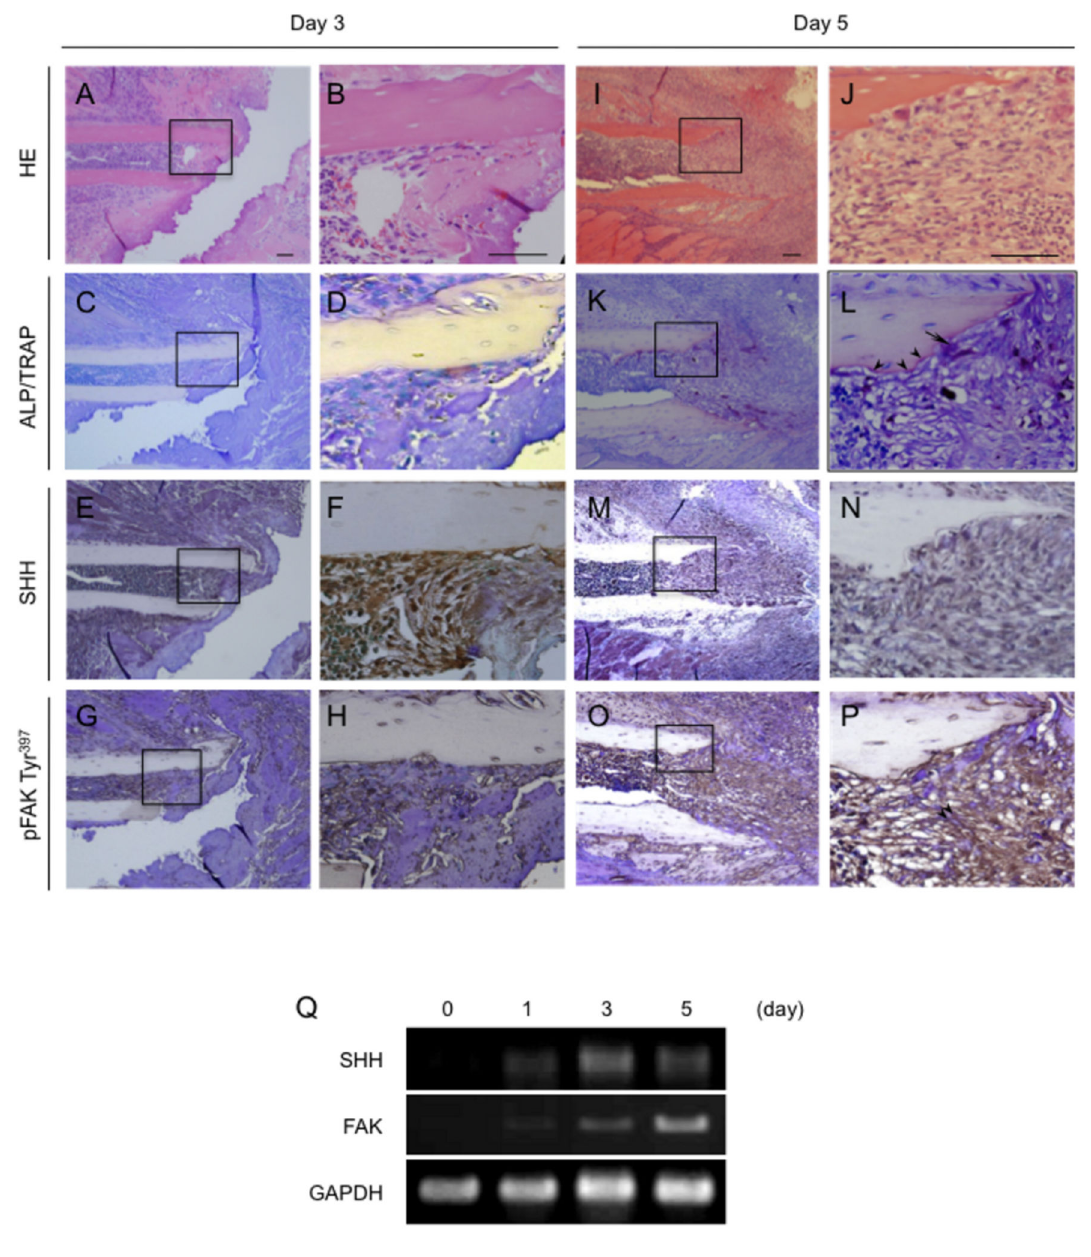
Figure 1. Histological appearance and localization of SHH and pFAK Tyr 397 in fractured mouse ribs at the early stage after fracturing. A-P, Photomicrographs show the healing process at 3 (A-H) and 5 (I-P) after fracturing. Sections were stained with HE (A, B, I and J) or for ALP and TRAP (C, D, K, and L), SHH (E, F, M, and N), and pFAK Tyr 397 (G, H, O, and P). Q, RT-PCR analysis of tissue samples containing ribs and surrounding tissues within 3 mm from the fracture line on days 1, 3, and 5 after the operation. Each right photo showing a histological section is a magnification of the rectangle-delimited area in the corresponding left photo Bar, 100 µm. Arrowheads: osteoblasts. Arrow: osteoclast. Double arrowheads: migrating bone marrow cells. The data from a typical experiment are presented: similar results were obtained in repeated experiments. doi: 10.1371/journal.pone.0076785.g001 However, SHH had no effect on the adhesion of control,